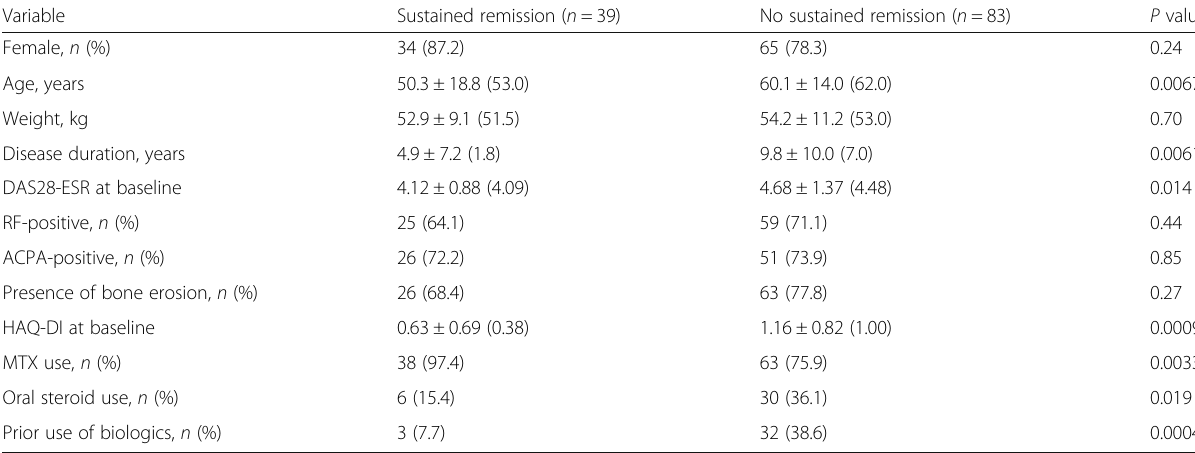
Table 2 Baseline characteristics correlated with sustained remission